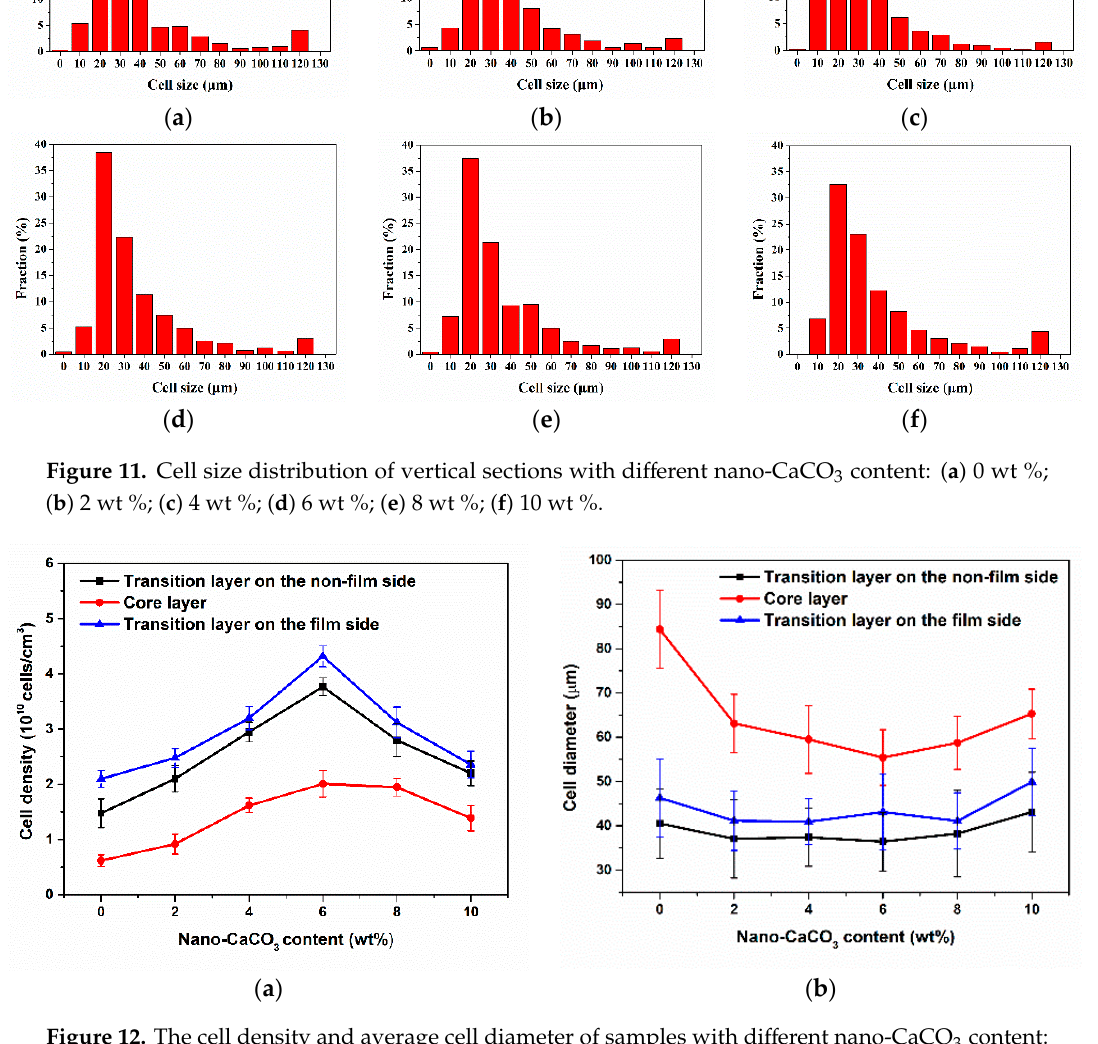
Figure 12. The cell density and average cell diameter of samples with different nano-CaCO 3 content: ( a ) cell density; ( b ) cell diameter. ( a ) cell density; ( b ) cell